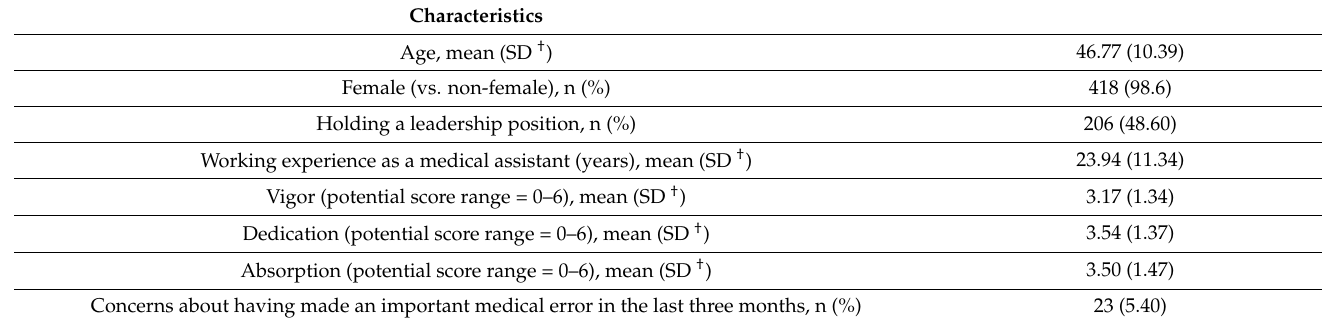
Table 1. Characteristics of the study population (n = 424).